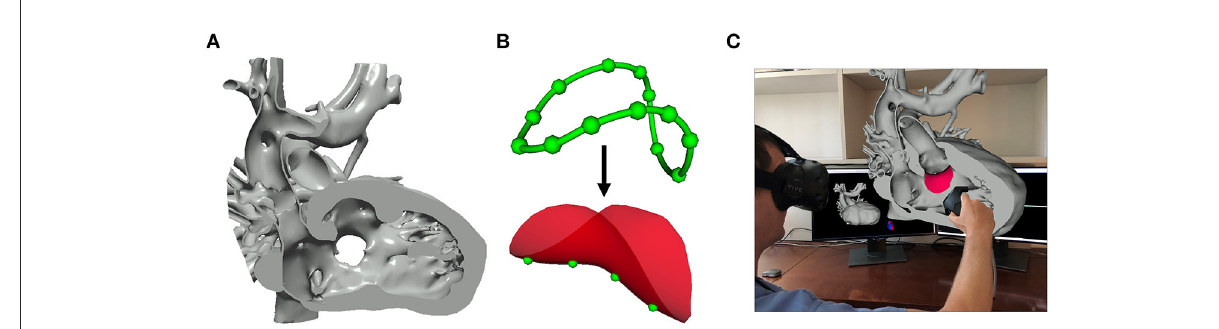
FIGURE9 Image-based planning of surgical procedures. (A) 3D virtual model of a heart with double outlet right ventricle anatomy cut to visualize the Ventricular Septal Defect that will be baffled to allow for continuous blood flow; (B) Closed baffle perimeter contour created by placing points in the 3D heart model which becomes a baffle model onto which surface points may be placed to customize the shape of the baffle; (C) Rendering demonstration visualization of the baffle model placed within the 3D heart model in SlicerHeart using the SlicerVR